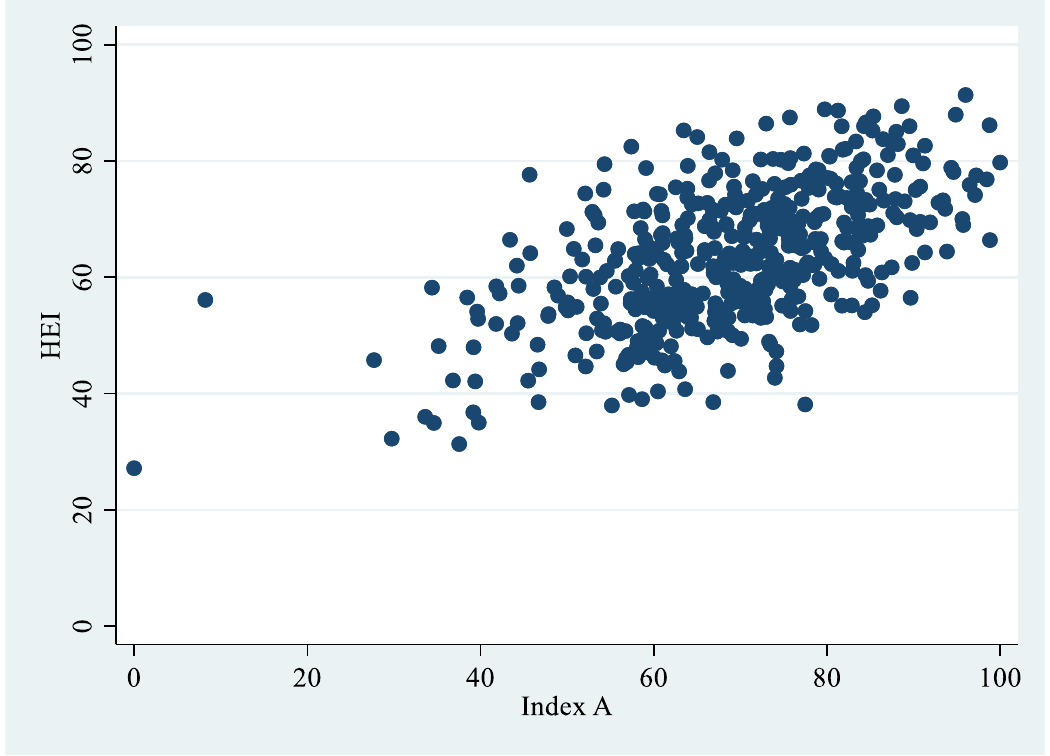
Figure 2. Correlation between HEI and Index A ( n =